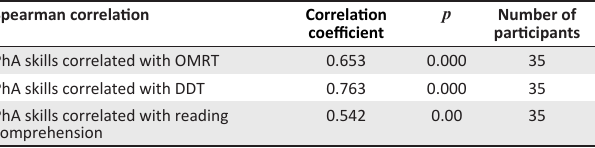
TABLE 5: Phonemic awareness skills correlated with the early reading